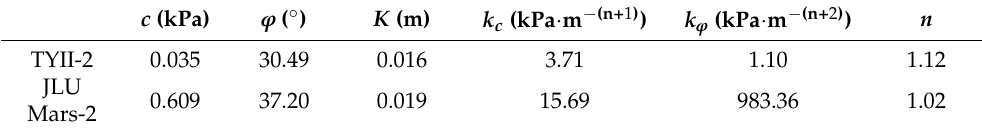
Table 1. The mechanical parameters of TYII-2 and JLU Mars-2.